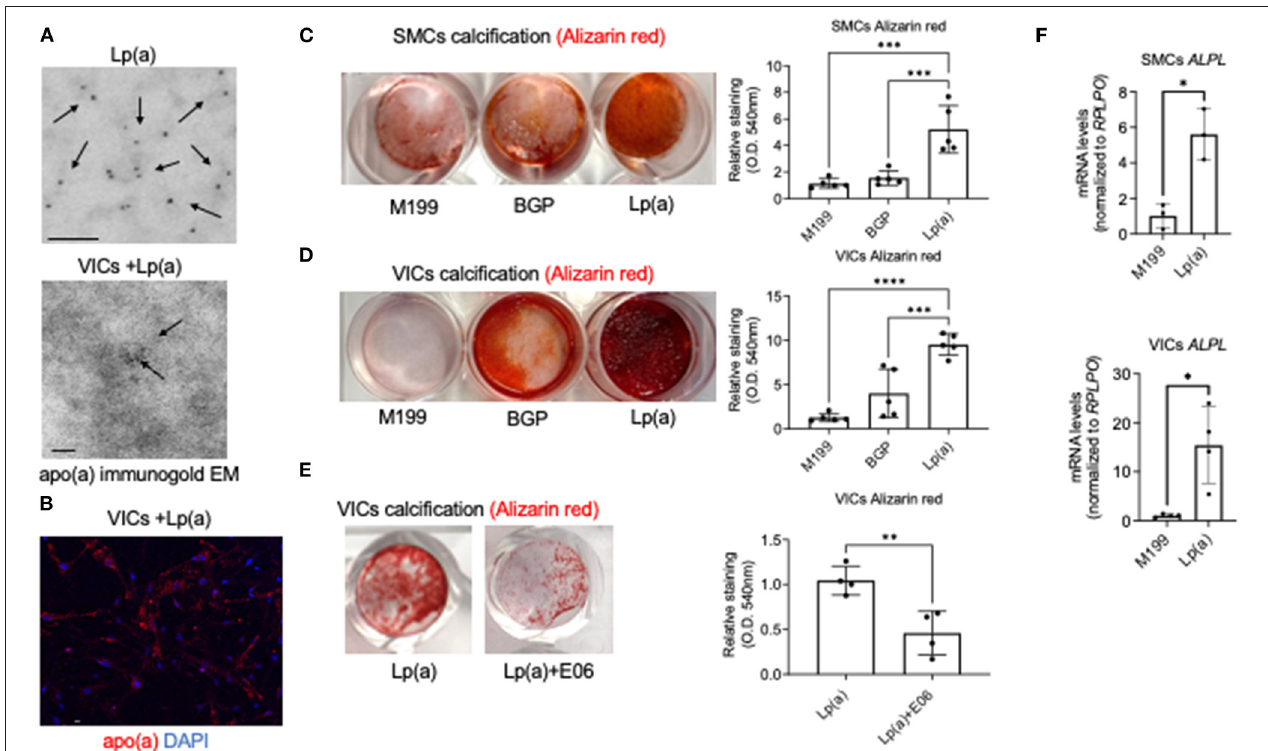
FIGURE 1 | Lp(a) accelerated human cardiovascular cell calcification that was suppressed by E06 antibody. (A) Apolipoprotein(a) immunogold electron microscopy of purified human Lp(a) and VICs incubated with Lp(a) ( n = 6 pooled donors). Arrows indicate examples of positive apolipoprotein(a) immunogold labeling; scale bars = 100nm. (B) Confocal immunofluorescence showing Lp(a) uptake in human VICs ( n = 5 donors, with an example image shown); scale bar = 20 µ m. (C) Calcification in human SMCs and (D) VICs incubated with control media (M199), or calcifying media containing organic phosphate (BGP) with and without Lp(a), labeled as Lp(a); n = 5 donors, analyzed by ANOVA. (E) Human VICs incubated as in B with the addition of E06 antibody; n = 4 donors, analyzed by Welch’s t-test. Example Alizarin red (calcification) images shown with quantification included. (F) Tissue non-specific alkaline phosphatase ( ALPL ) mRNA levels in SMCs and VICs incubated in control and calcifying media with Lp(a); n = 3 donors for SMCs and 4 donors for VICs. Error bars are STDEV, * P < 0.05, ** P < 0.01, *** P < 0.001, **** P <